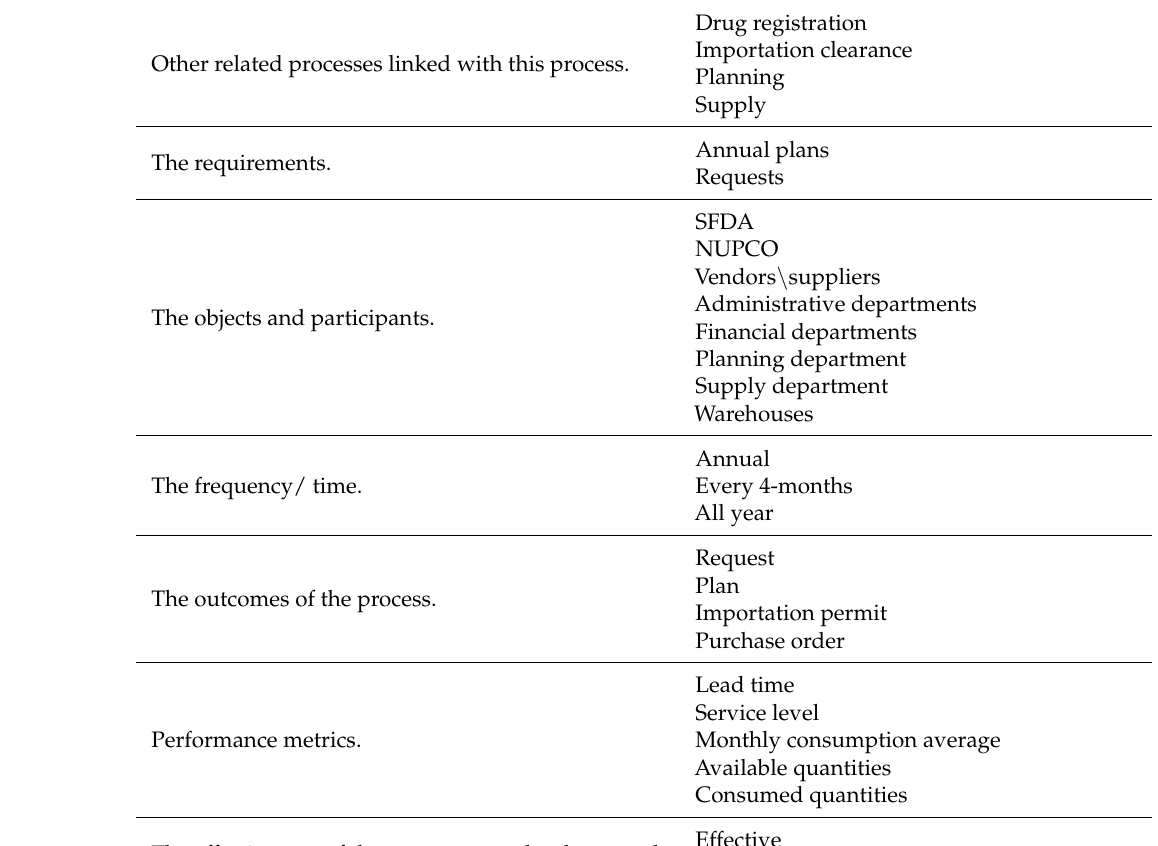
Other related processes linked with this